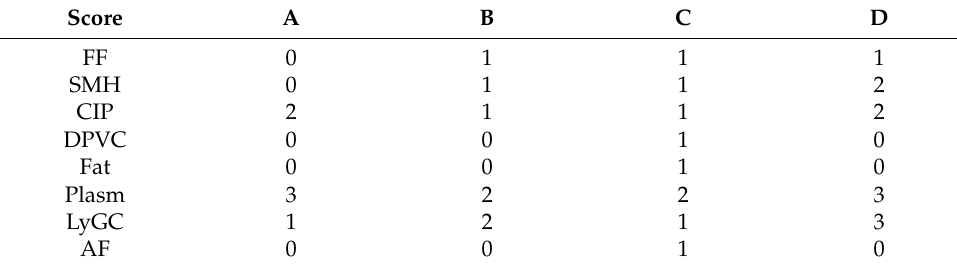
Figure 2. The case of idiopathic pulmonary fibrosis showing CTD-like histopathological features. ( A ): the whole image of VATS tissue shows a peripheral distribution and abrupt change. (HE, ×0.5). ( B ): dense fibrosis and fibroblastic focus suggesting UIP are seen. (HE, ×100). ( C , D ): a large number of lymphoid follicles with germinal centers and plasmacytic infiltration are found in the interstitium, indicating collagen disease. CTD, connective tissue disease; VATS, video-assisted thoracoscopy; UIP, usual interstitial pneumonia; HE, hematoxylin and eosin. Table 3. The scores for the case from